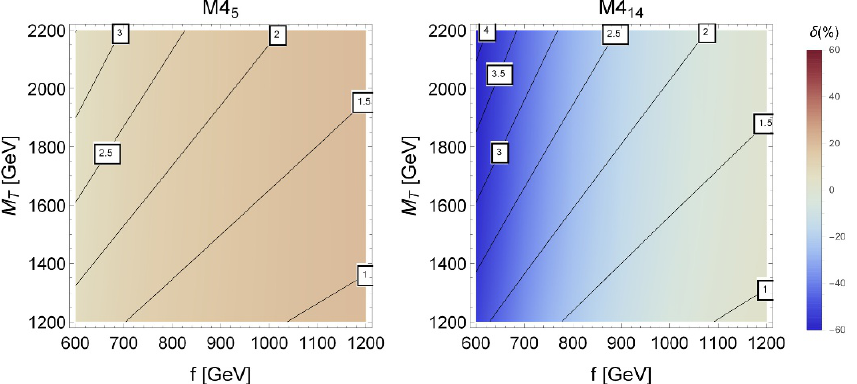
Figure 11 . The contour plots of (cid:14) ( p cut ) with sin 2 (cid:18) R = 0 : 1 and p cut = 600 GeV for each of the T T fourlet models with one top partner multiplet. The corresponding values of y are indicated by the solid lines. None of the parameter space on these plots result in (cid:20) t (cid:20) 0 : 8.